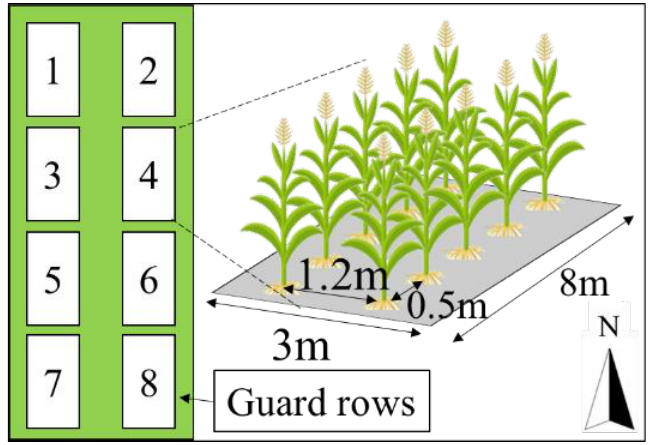
Figure 1. Diagram of experimental plots.